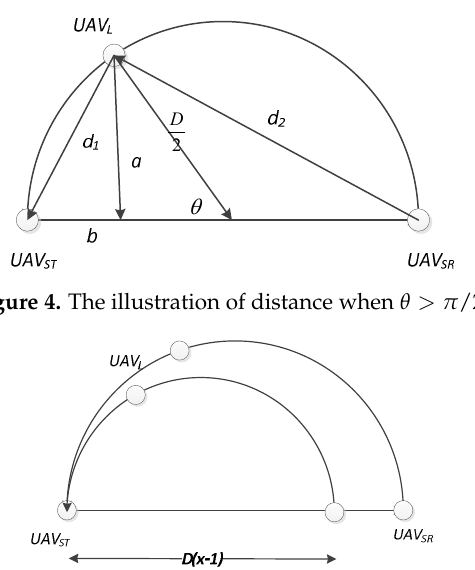
Figure 3. The illustration of distance when θ < π /2.